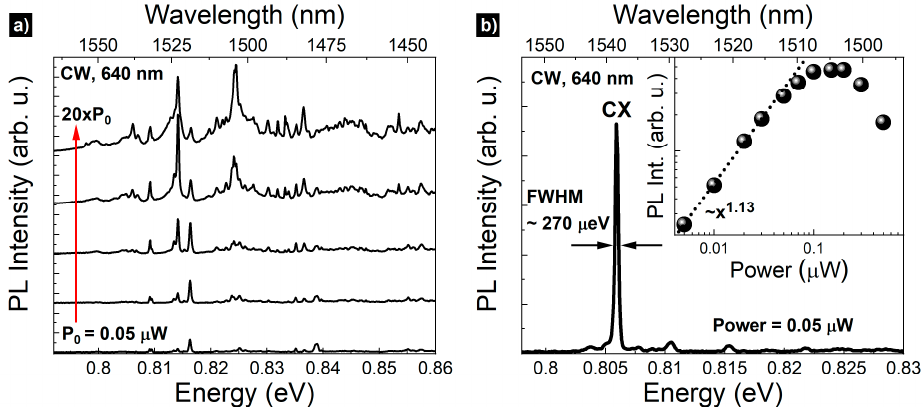
Figure 2. ( a ) Broad range µ PL spectrum from planar structure as a function of excitation power from 0.05 µ W to 1 µ W (red arrow); ( b ) µ PL spectrum from a single QD under cw excitation (640 nm). Inset: intensity of the charged exciton (CX) as a function of the excitation power with the power function fit (dotted line).